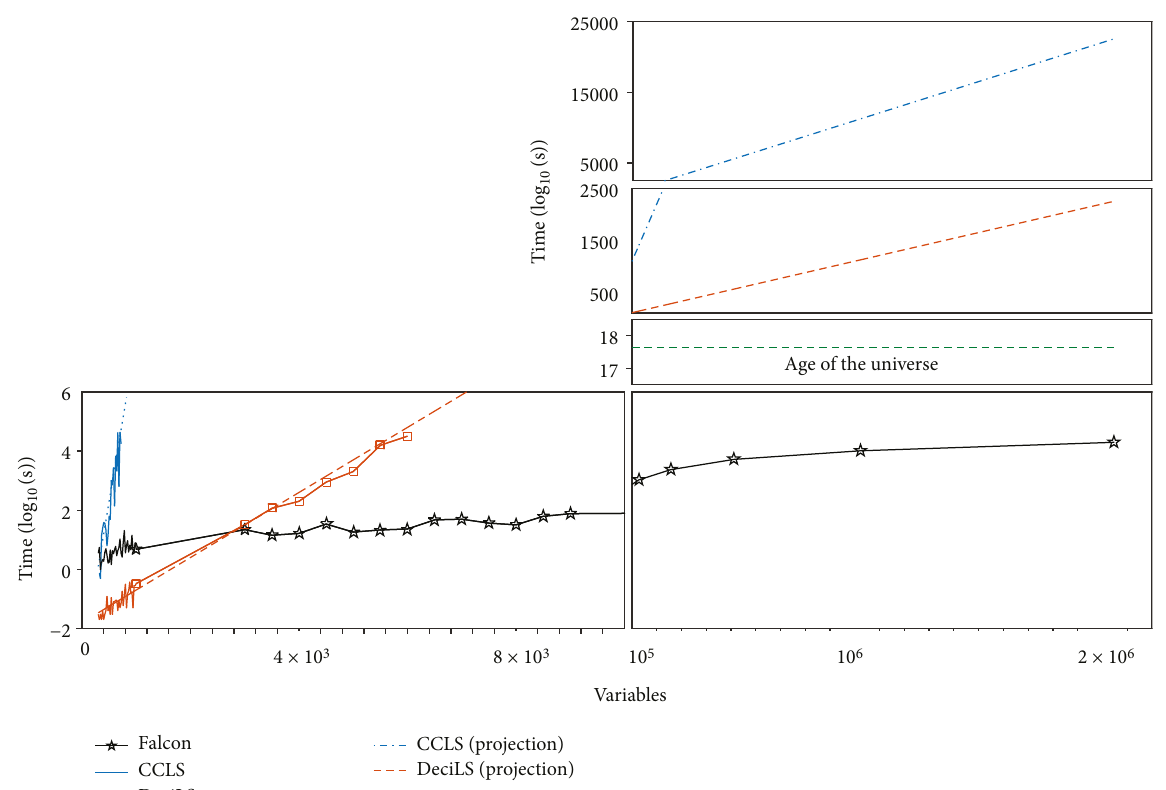
Figure 2: Simulation time comparison between incomplete solvers CCLS and DeciLS against our solver, Falcon, for the balanced and constrained delta-Max-E3SAT. A threshold of 1 5% of unsatis fi able clauses has been set. We have then tested how long CCLS, DeciLS, and our solver Falcon take to overcome this limit with increasing number of variables. All calculations have been performed on a single thread of an Intel Xeon E5-2680 v3 with 128Gb DRAM shared on 24 threads. The local solvers require an exponentially increasing time to reach that limit already visible at a few hundred variables for the CCLS and a few thousands for the DeciLS. Our solver has been tested up to 2 × 10 6 variables and required order of 10 4 seconds for that maximum number of variables. We show also the estimate of time that would have been required these local solvers to run up to 2 × 10 6 variables. The estimated time (dashed and dashed-dotted lines) has been time versus the number of calculated using a linear regression of the log 10